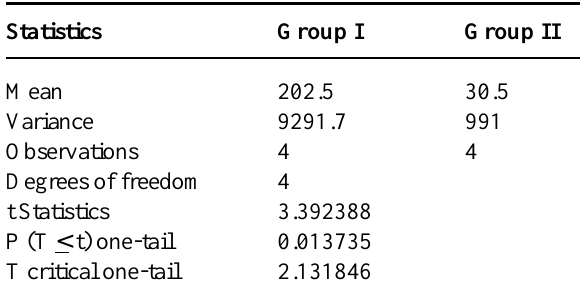
Table 3 – “t” test according to bladder capacity (mL) at 6